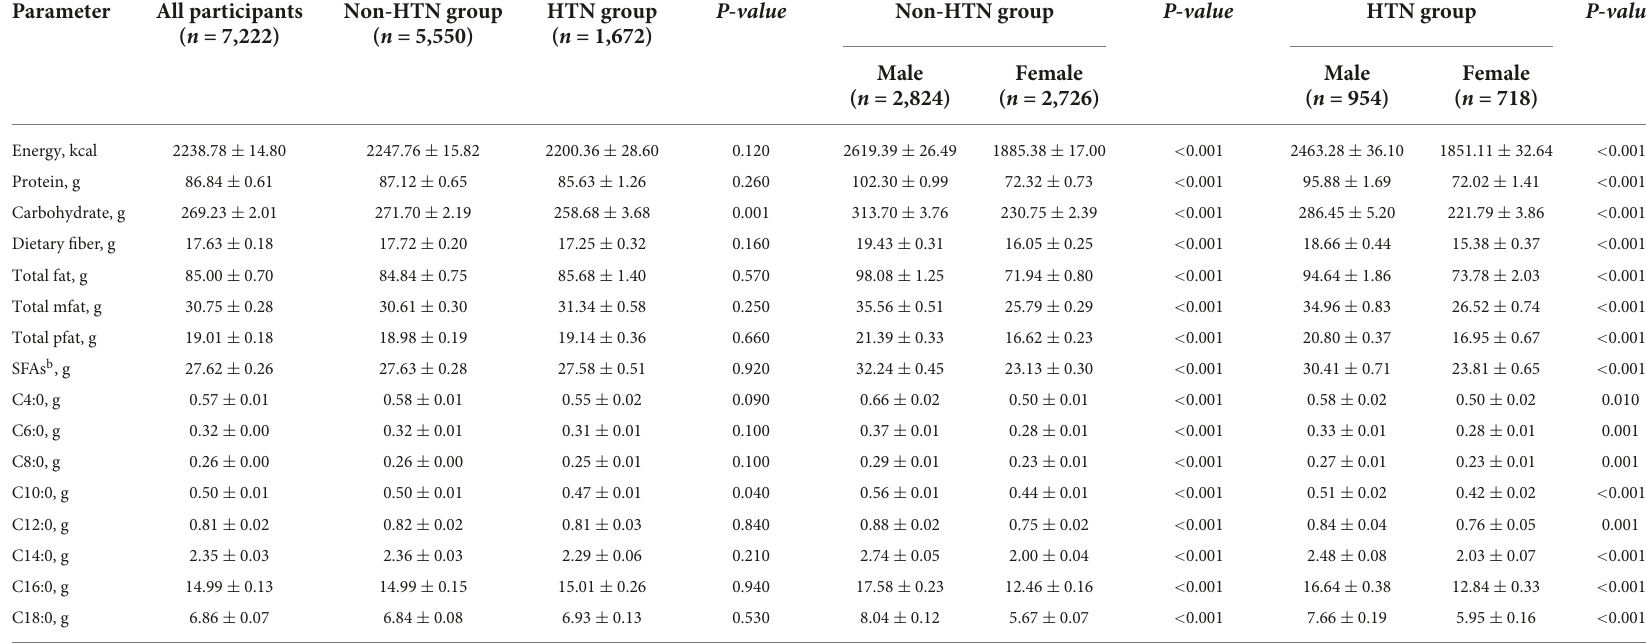
TABLE 3 Characteristics of the weighted dietary intake of nutrients in the hypertensive and non-hypertensive groups among the participants a .